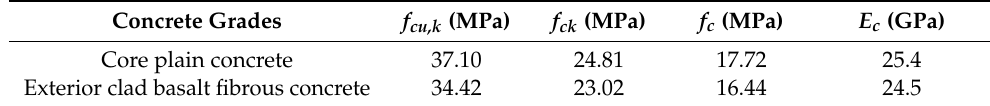
Table 2. Material properties of concrete.